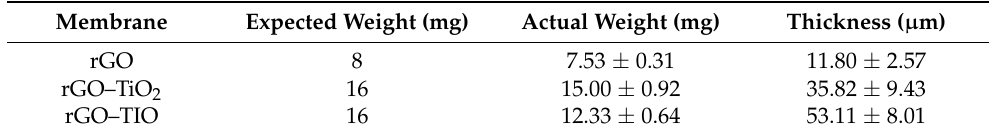
Table 1. Weight and thickness of the produced membranes.